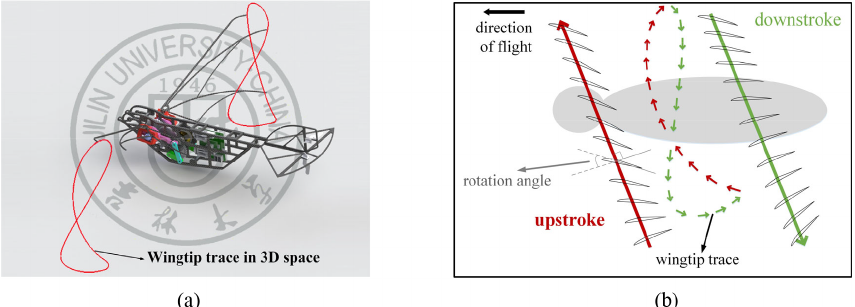
Figure 6. Simulating diagram of FWMAV movement. (a) Wingtip path of figure eight with SolidWorks. (b) Wing cross section in a lateral view at various instances.